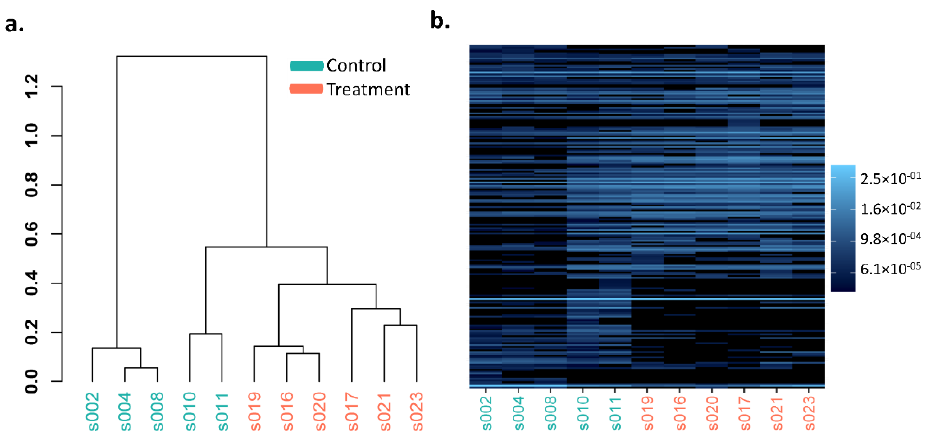
Figure 4. Genus level Bray–Curtis dissimilarity comparisons in the GI microbiota dysbiosis (treat ‐ ment) ( n = 6) and control ( n = 5) groups. ( a ) Hierarchical clustering, ( b ) heatmap.